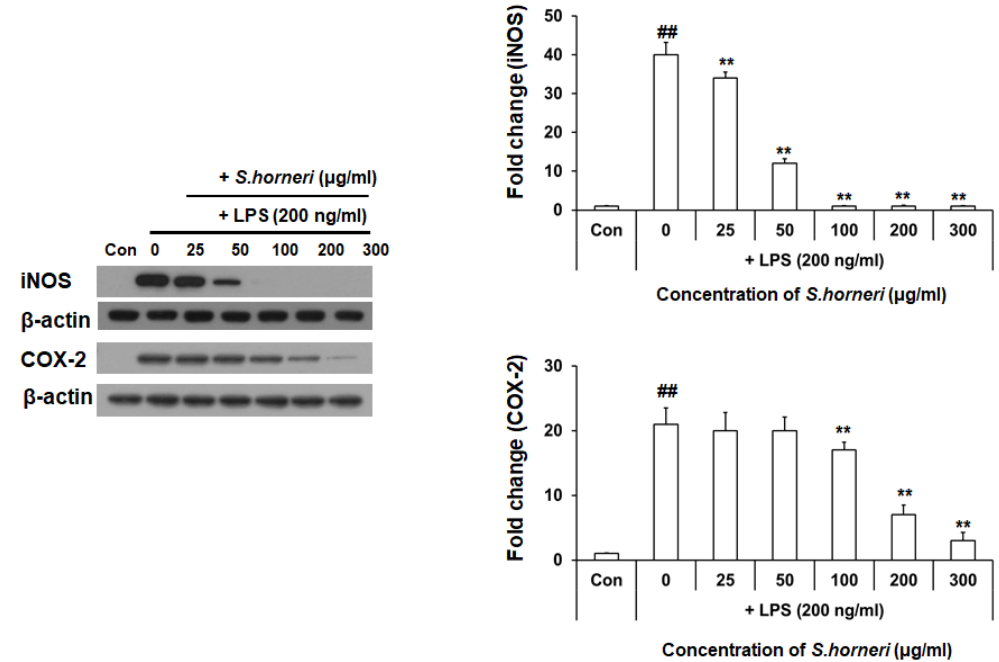
Figure 2. Effect of S. horneri extract on protein expression of iNOS and COX-2 in LPS-stimulated BV-2 microglial cells. S. honeri extract was pretreated with BV-2 microglial cells 2 hr and then in- cubated with 200 ng/mL LPS for 22 hr. iNOS and COX-2 protein expression was determined by Western blot. The result is representative of three repeated independent experiments. Experimental results were indicated as mean (±SE). ** p < 0.001, significantly different from LPS-treated group; ## p < 0.001, significantly different from LPS-untreated group.